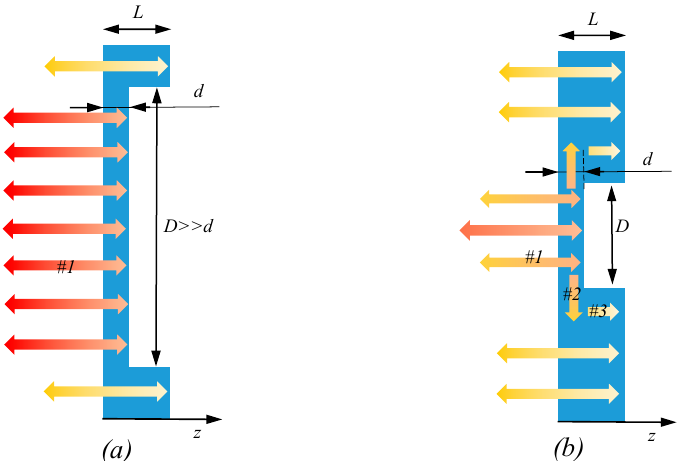
Figure 2. Comparison of the effect of defect ( a ) infinite and ( b ) finite lateral extension on heat diffusion, retrieved from [1].